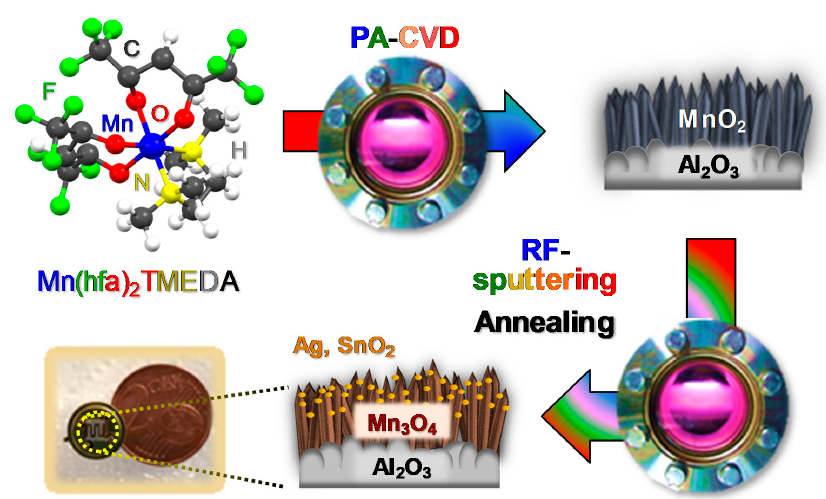
Figure 1. Scheme of the route proposed in the present study for the fabrication of Mn 3 O 4 -Ag and Mn 3 O 4 -SnO 2 nanomaterials.